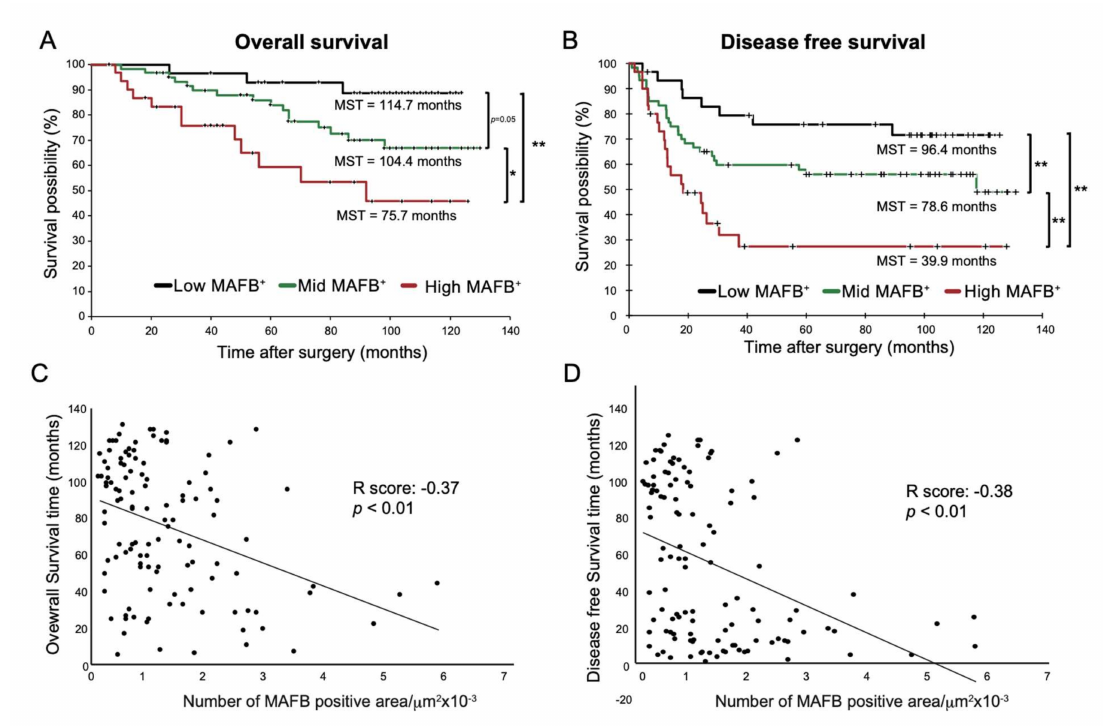
Figure 3. OS and DFS of low-, mid-, and high- in MAFB + cells Kaplan–Meier analysis of ( A ) overall survival and ( B ) disease-free survival of the three groups: low-MAFB + , mid-MAFB + , and high- MAFB + . Difference in survival was compared using log-rank test. Pearson correlation analysis was performed between MAFB expression and ( C ) survival time (R score: − 0.366, p = 0.000043) and ( D ) disease-free survival (R score: − 0.378, p = 0.000023). Data are presented as means ± SEM; data is considered significant at * p < 0.05; ** p <